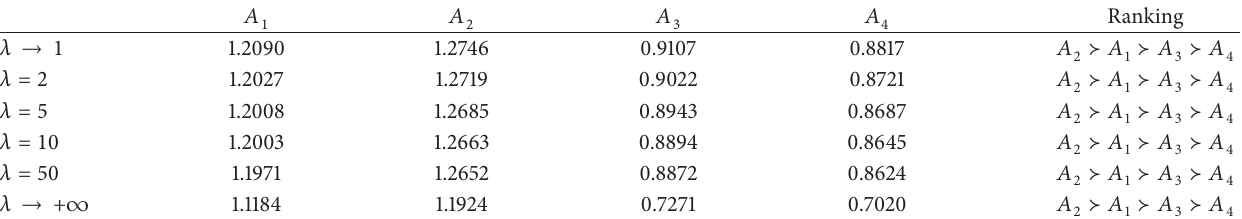
Table 6: Score values obtained by the TIT2FFWA operator and the rankings of